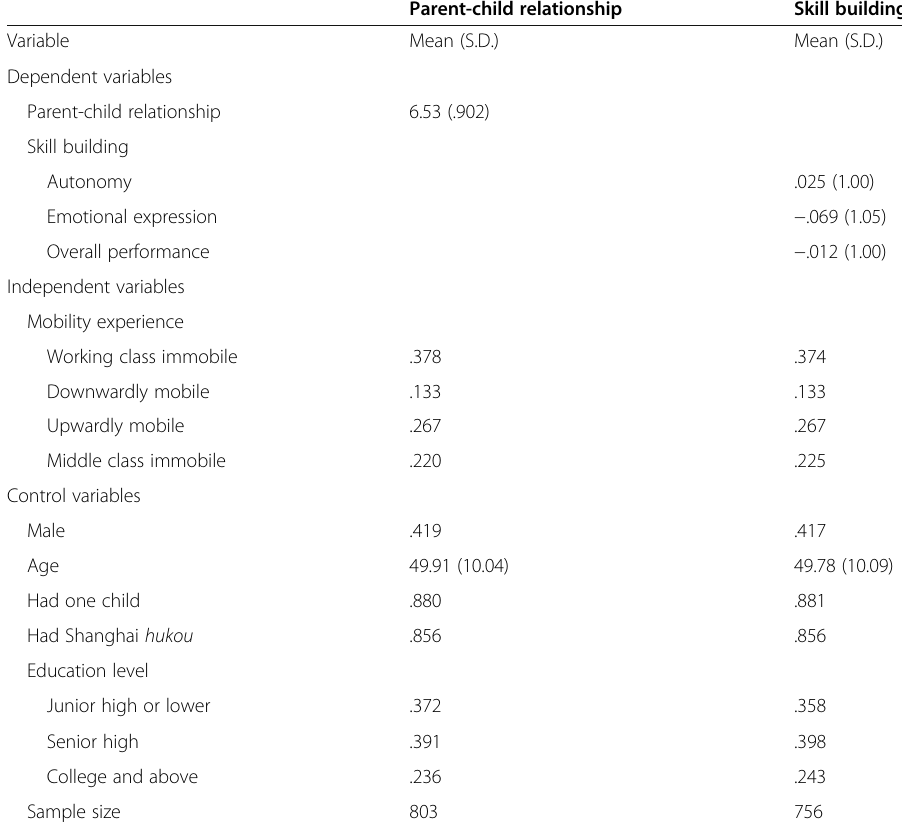
Table 3 Descriptive statistics of the SHFS 2010 Parent-child relationship Skill